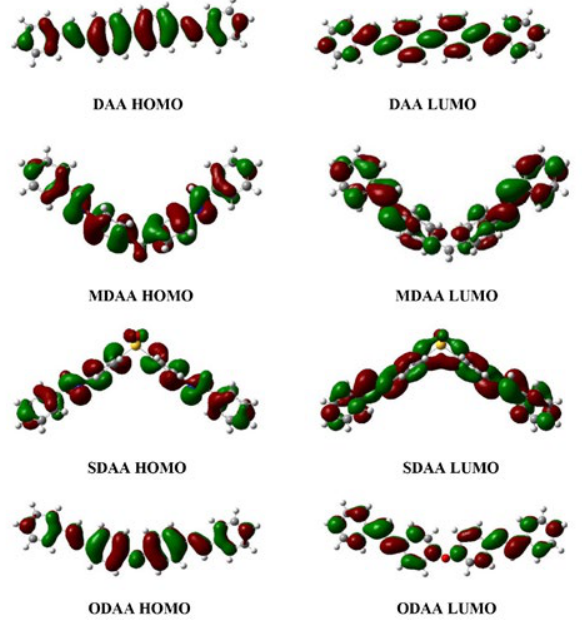
Figure 4: HOMO and LUMO orbitals of non-protonated inhibitor molecules using B3LYP/6-31G calculation level.